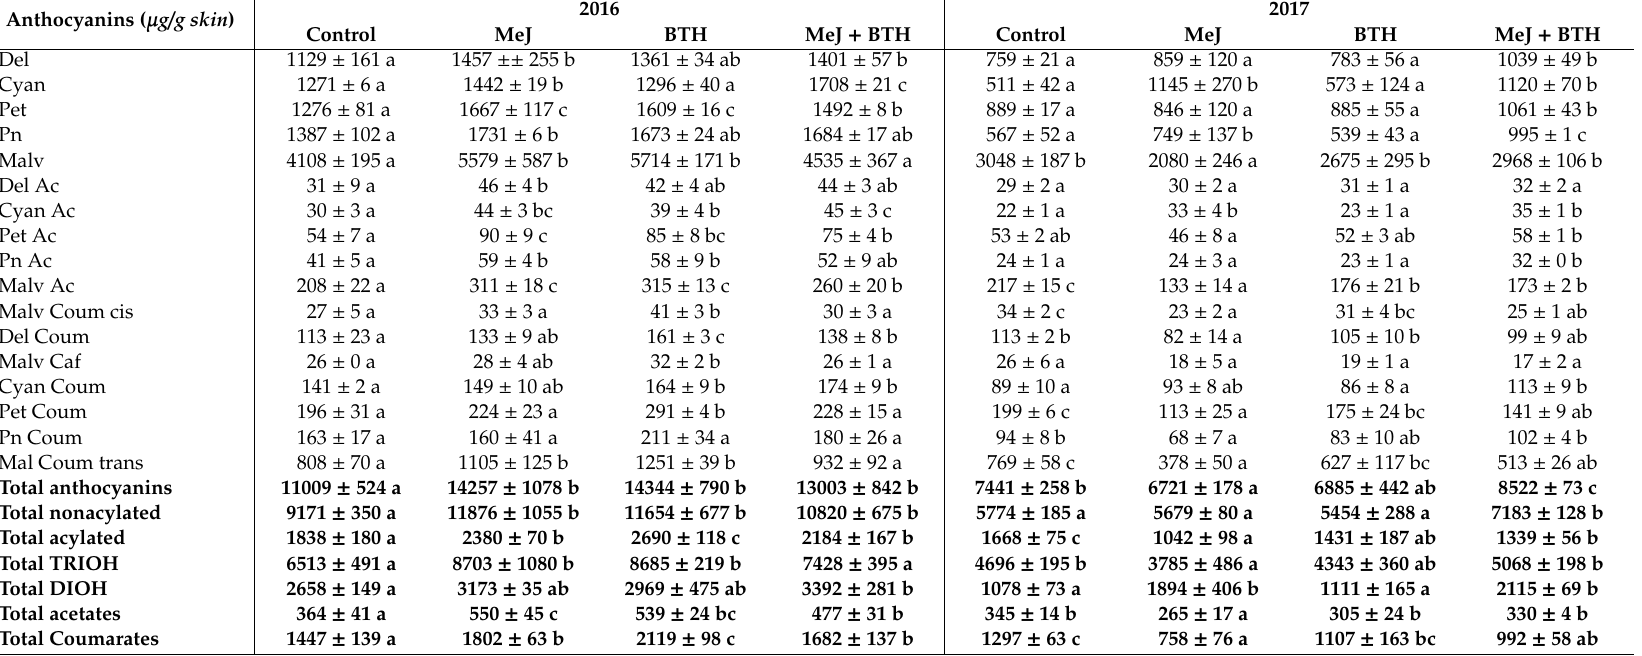
Table 1. Concentration of anthocyanins by HPLC in Monastrell grape berry skin treated with MeJ, BTH and MeJ +